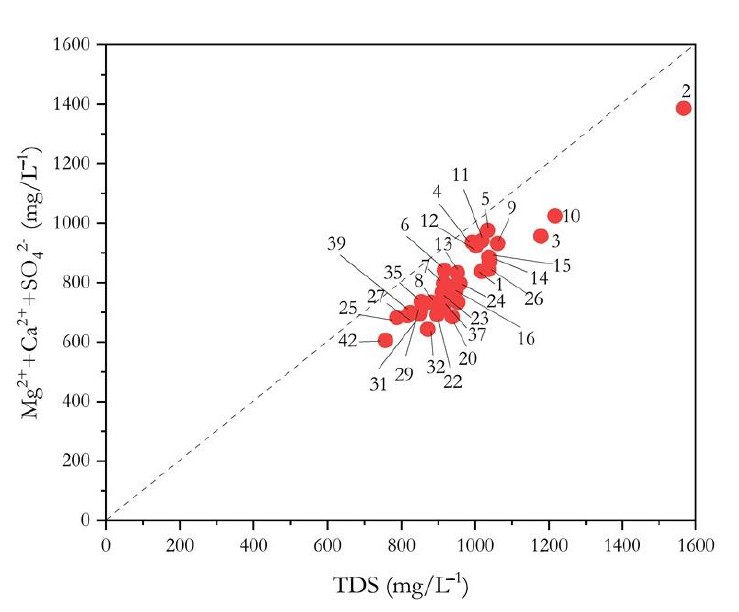
Figure 4. Mg + Ca + SO 4 (in mg/L −1 ) vs. TDS (in mg L −1 ) binary diagram. The IDs refer to the